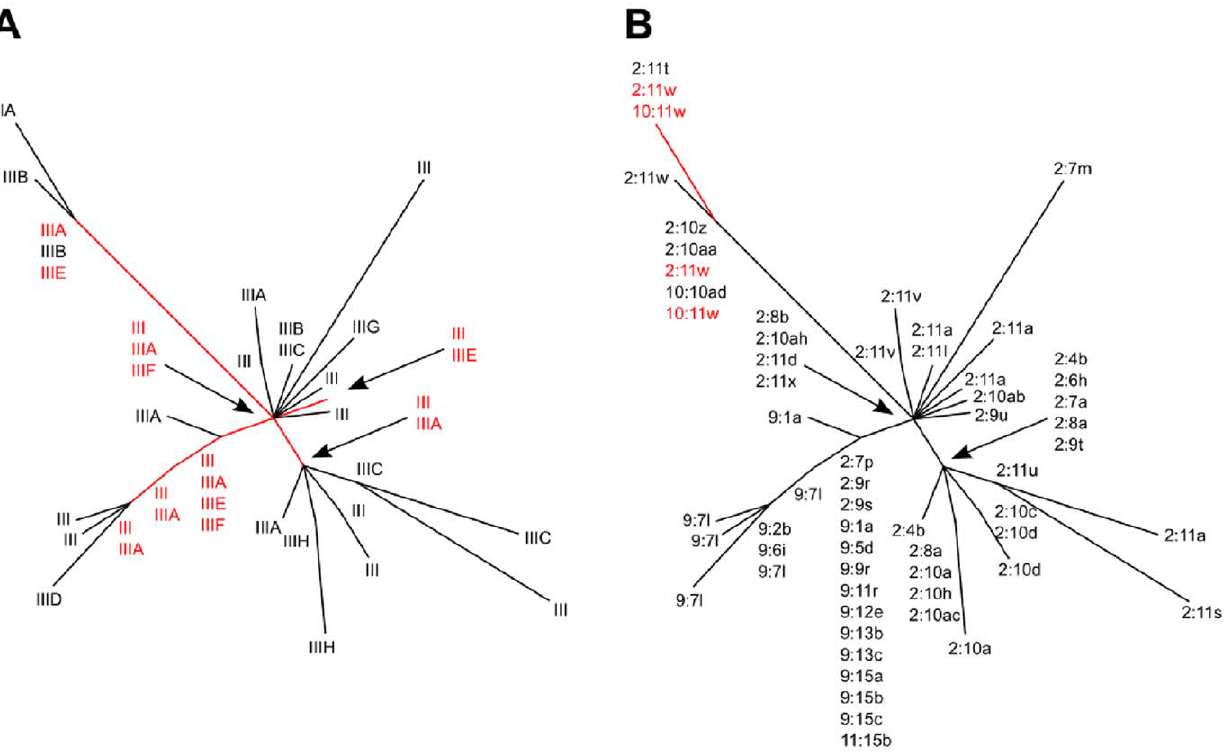
Figure 3. Homoplasy among SCC mec type III variants. (A) Mapping of SCC mec multiplex PCR types onto the haplotype tree of Figure 1. (B) Mapping of SCC mec ccrB:dru sequence types onto the haplotype tree of Figure 1. Red highlights homoplasy where two SCC mec subtypes occur together in more than one haplotype. doi:10.1371/journal.pone.0008582.g003 PLoS ONE |